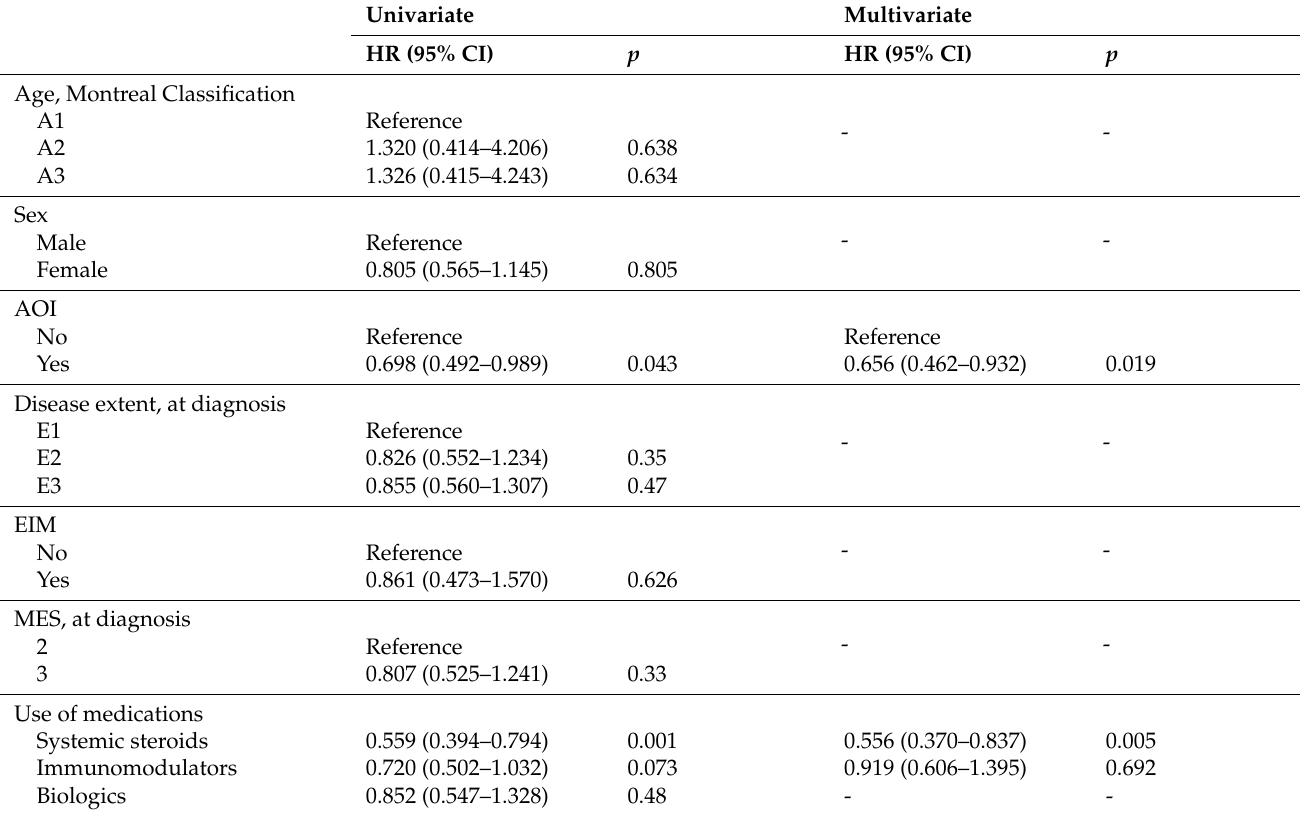
Table 2. Cox proportional hazards model for clinical factors associated with complete endoscopic